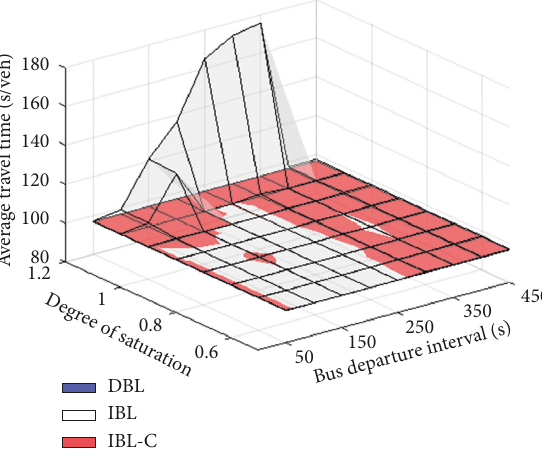
Figure 10: Bus average travel time with near-side bus stop.